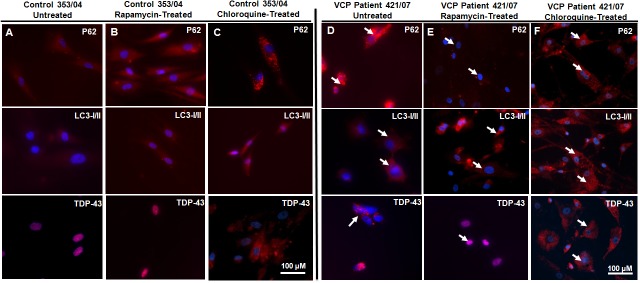
Immunohistochemical analyses of autophagy signaling cascade in the patients’ myoblasts with VCP disease treated with either rapamycin or chloroquine.Control 353/04 (A) untreated, (B) 10μM rapamycin-treated myoblasts, (C) 10μM chloroquine-treated myoblasts stained with p62/SQSTM1 (upper panel), LC3-I/II (middle panel) and TDP-43 (lower panel) antibodies for 24 hours. VCP patient 421/07 (D) untreated (white arrows represent increased p62/SQSTM1, LC3-I/II and mislocalized TDP-43), (E) 10μM rapamycin-treated myoblasts (arrows indicated decreased expression levels of p62/SQSTM1, LC3-I/II and nuclear TDP-43), (F) 10μM chloroquine-treated (white arrows represent increased p62/SQSTM1, LC3-I/II and mislocalized TDP-43) myoblasts stained with p62/SQSTM1 (upper panel), LC3-I/II (middle panel) and TDP-43 (lower panel) antibodies for 24 hours. Scale bar represents 100 μM. Data represents triplicate studies.